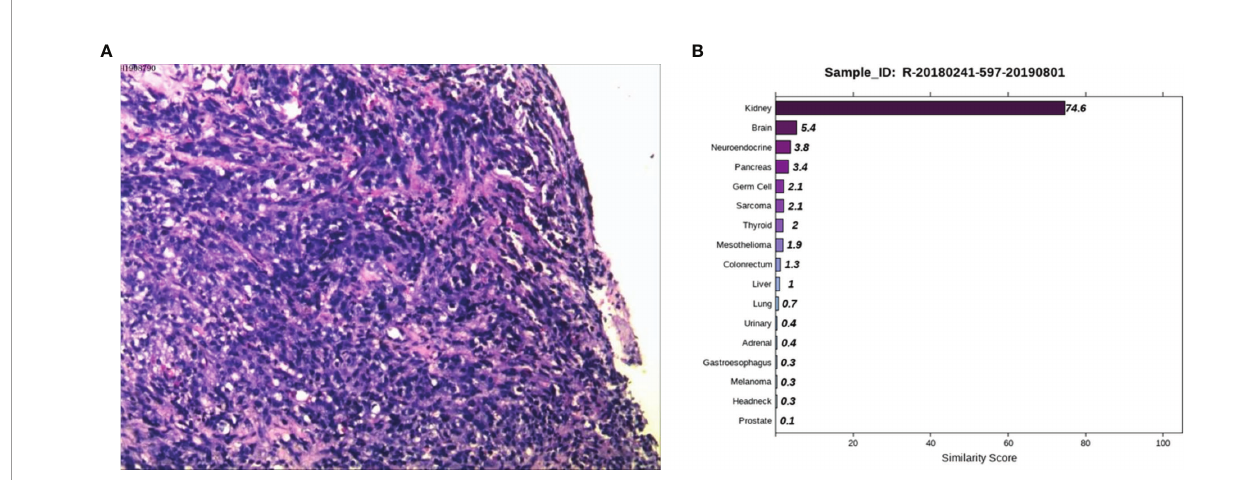
FIGURE 2 | Pathological and 90-gene expression assay results of case 2. (A) The pathological results showed diffuse proliferation of spindle cells, atypical epithelioid cells in a sheet-like distribution, and necrosis and bone formation were seen. Immunohistochemical staining con fi rmed CK, LCK, Hep (focally), Urop3 nucleus as positive. (B) The 90-gene expression assay indicated that there is a 74.6 similarity score of metastatic renal cancer on the right side of the